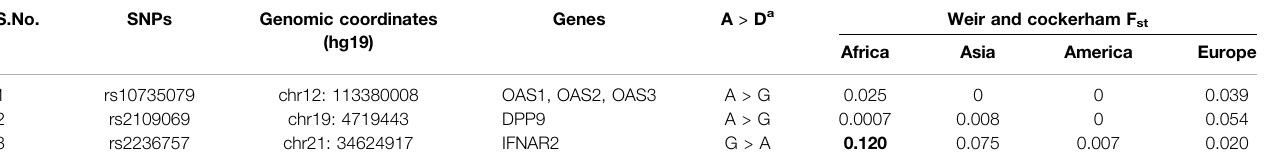
TABLE 1 | Weir and Cockerham F st values evaluated for SNPs rs10735079, rs2109069 and rs2236757. S.No. Genomic coordinates Genes A > D (hg19)